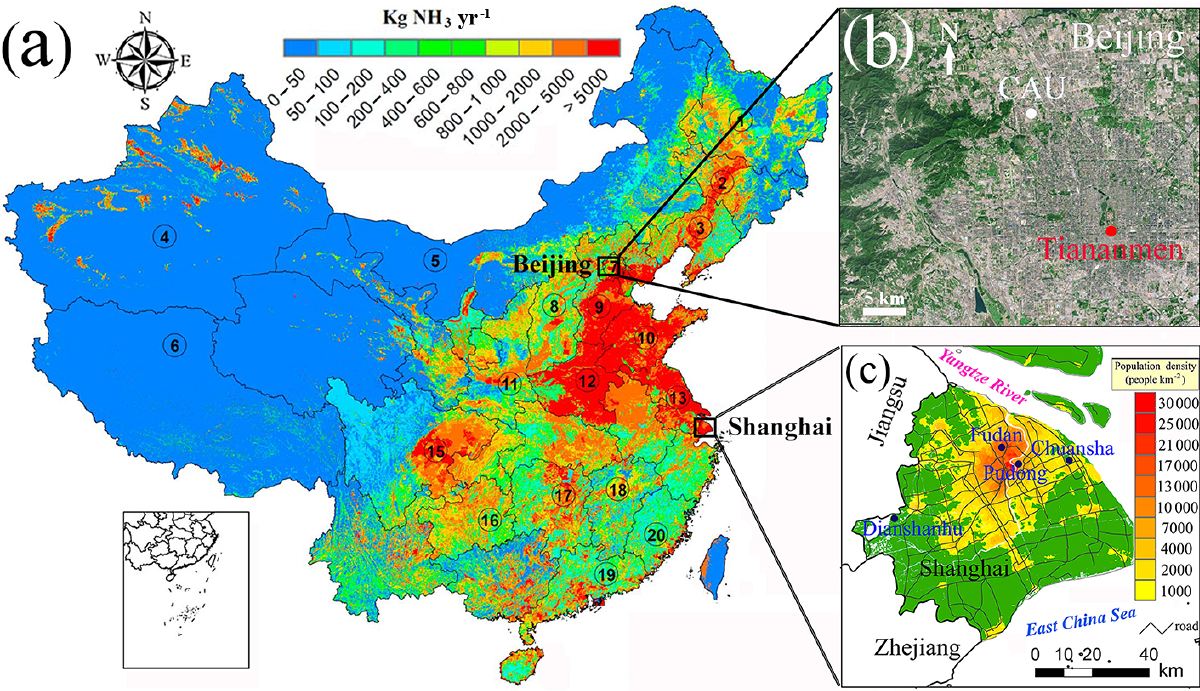
Figure 1. (a) 1km × 1km gridded NH 3 emission inventory in China in 2006 (modified from Huang et al., 2012). (b) Location of the sampling site (China Agricultural University or CAU) in this study and its spatial position relative to Tiananmen Square (Beijing urban center). (c) Atmospheric NH 3 monitoring network in